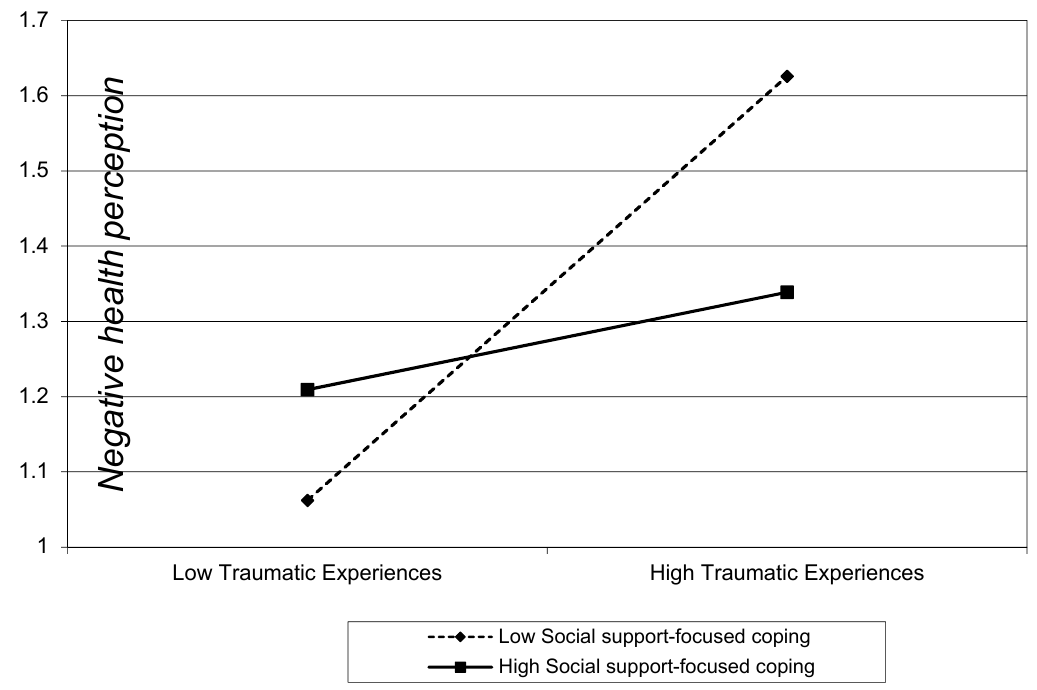
Figure 2. Moderation effect of support-focused coping on the association between traumatic experiences and negative health perception. Range of traumatic experiences and support-focused coping are from (mean –1 SD) to (mean +1 SD). These are the variables before being centered to 0.